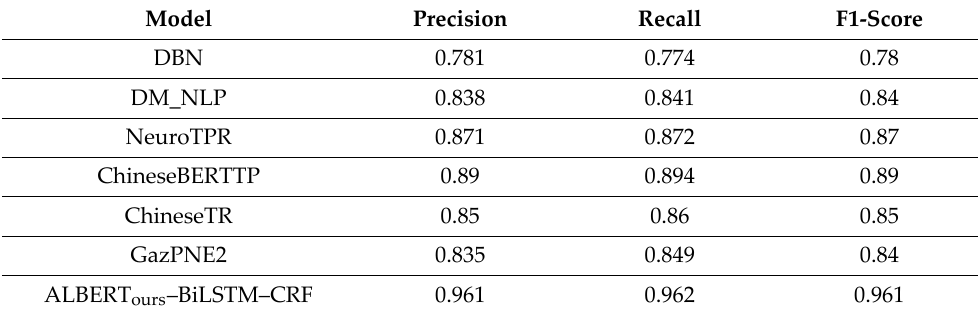
Table 10. Comparison with previous works on TPCNER. Model Precision Recall